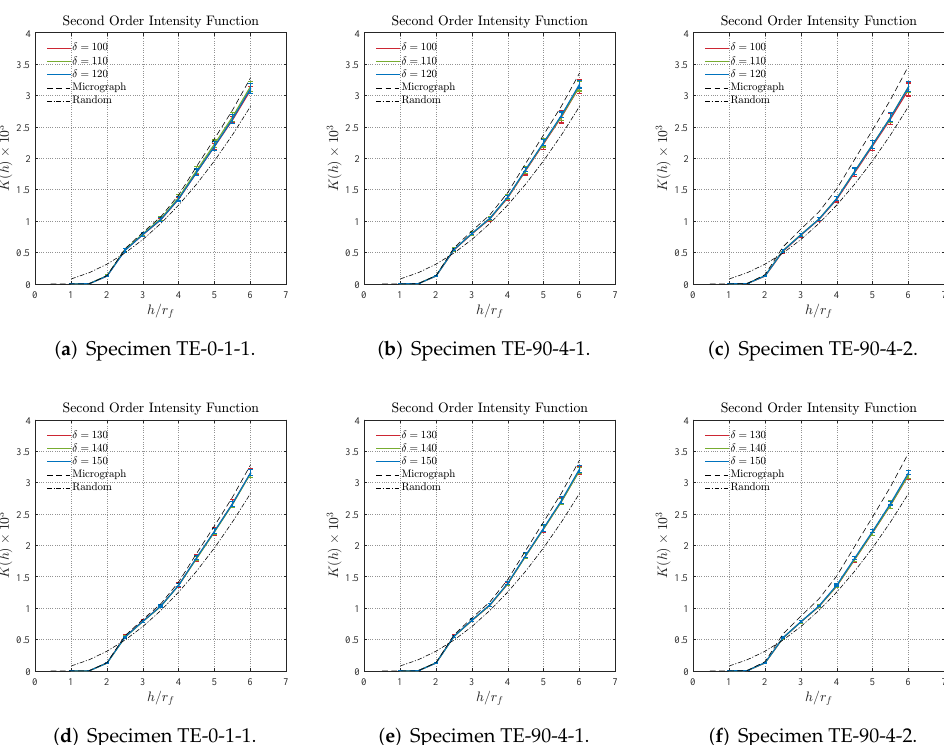
Figure 14. Second-order intensity function obtained for cropped regions of size δ = [ 100,150 ] , as well as for the main region of the cross-section micrograph (dashed lines) and for a complete random distribution (dash-dotted